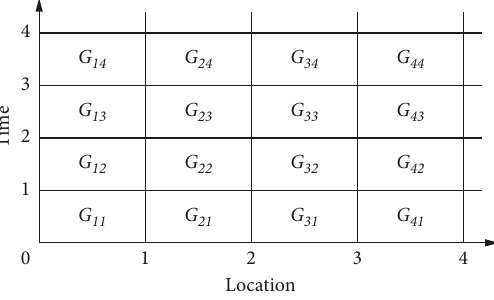
Figure 2: Diagram of railway time-location